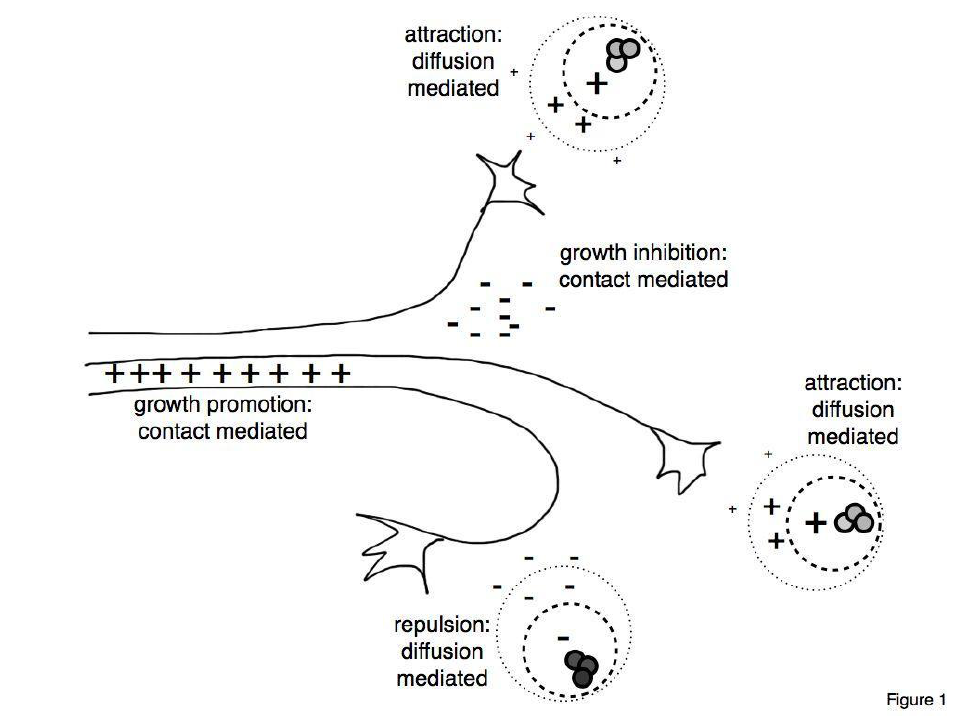
Figure 1. Schematic drawing of axonal guidance. Neuronal growth cones sense their environment with surrounding cells or extracellular matrix, select their preferable pathway, and avoid unfavorable regions. Molecules influencing behaviors of the growth cones are referred to as guidance cues. The molecules encouraging axonal growth are called “attractive guidance cues” and promote axonal growth in a contact-mediated manner or attract growth cones in a diffusion-mediated manner. The molecules keeping away the growth cones are called “repulsive guidance cues” and inhibit growth in a contact-mediated manner or repulse growth cones in a diffusion-mediated